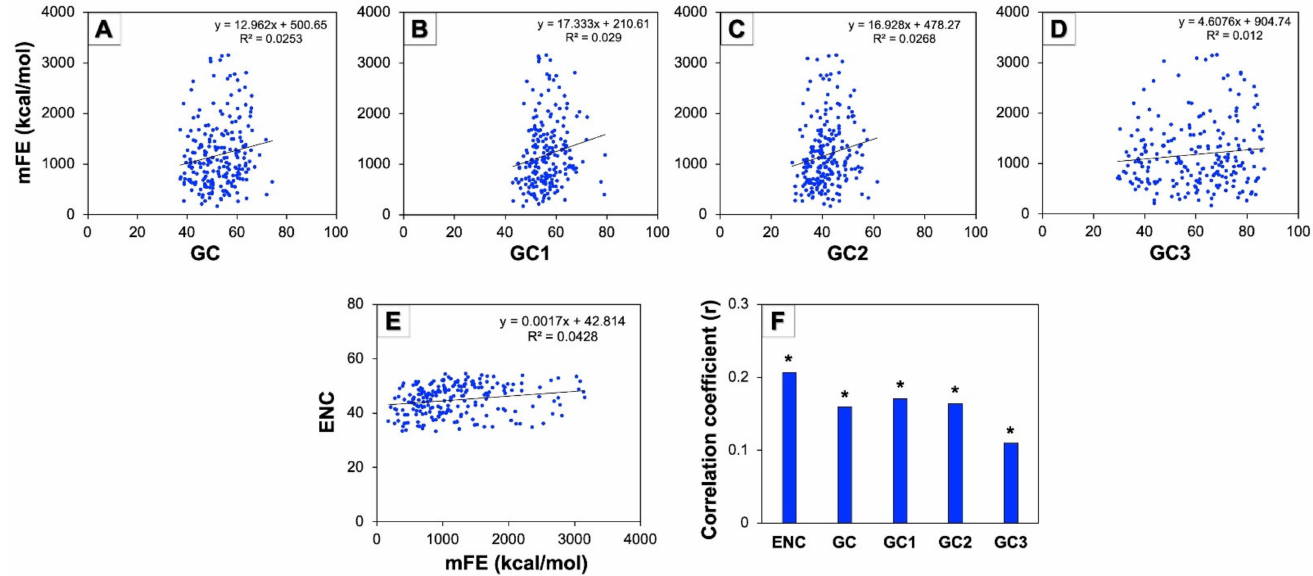
Figure 8. Role of mFE of genes involved in human autophagy on CUB. ( A – D ) represent the regression plots between mFE and GC contents in all genes. ( E ) represents the regression plot between ENC and mFE. ( F ) represents the distribution of the correlation coefficient of mFE against ENC and various GC contents such as overall GC, GC1, GC2, and GC3. For these analyses, absolute values of mFE were considered (* represents p <